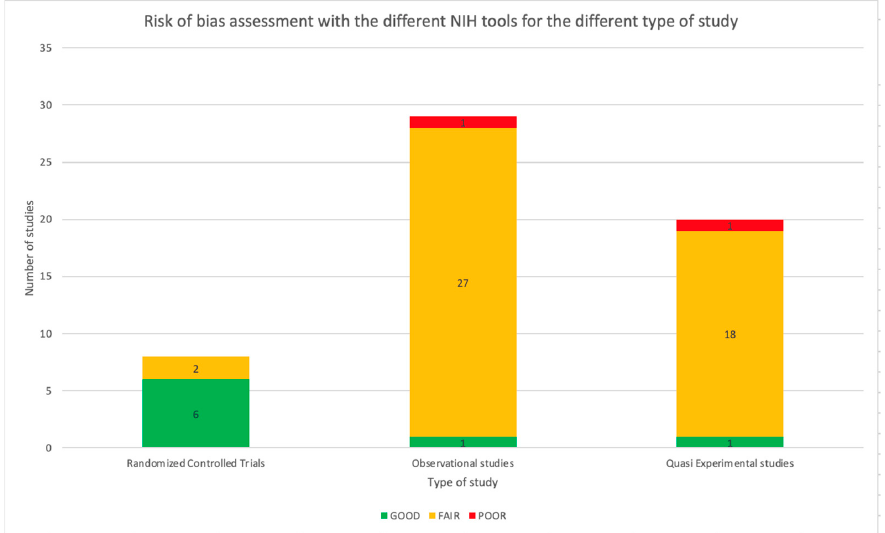
Figure 8. Risk of bias assessment with the different NIH tools for the different types of studies